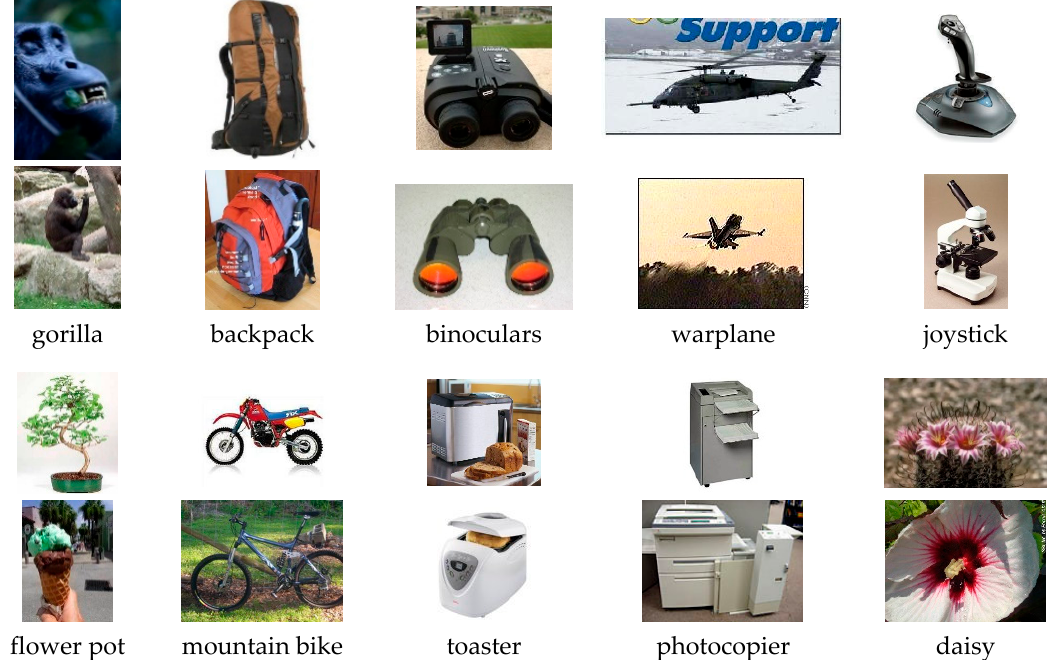
Figure 3. Examples of Caltech256 dataset images classified under the same class by AlexNet. 192